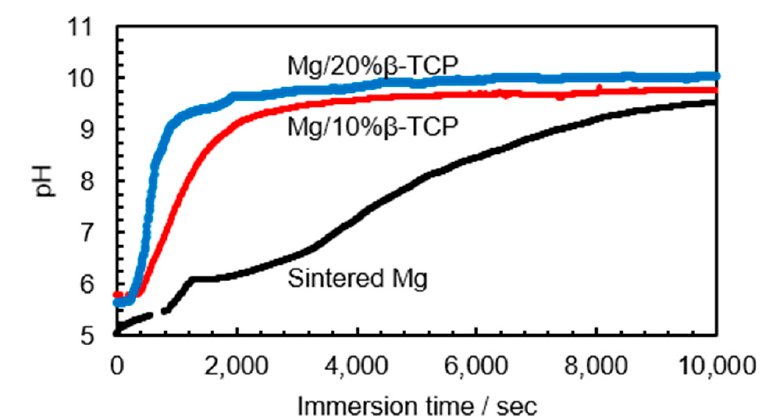
Figure 5. Changes of pH values in the initial 2.5 h after immersion in physiological saline.